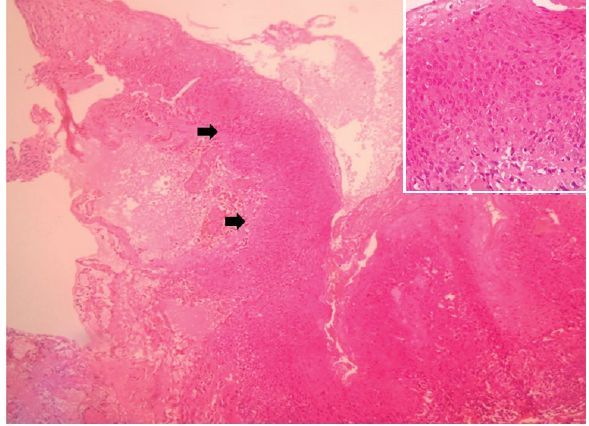
Figure 2: Photomicrograph showing tissue lined by stratified squamous epithelium with the focal area with dysplastic epithelium involving almost entire thickness. Maturation is maintained. (HE stain; X100) Inset showing loss of polarity and abnormal mitosis. (HE stain; X400) DISCUSSION OSSN is the third most common ocular tumor after melanoma and lymphoma and is known to have a varied presentation.